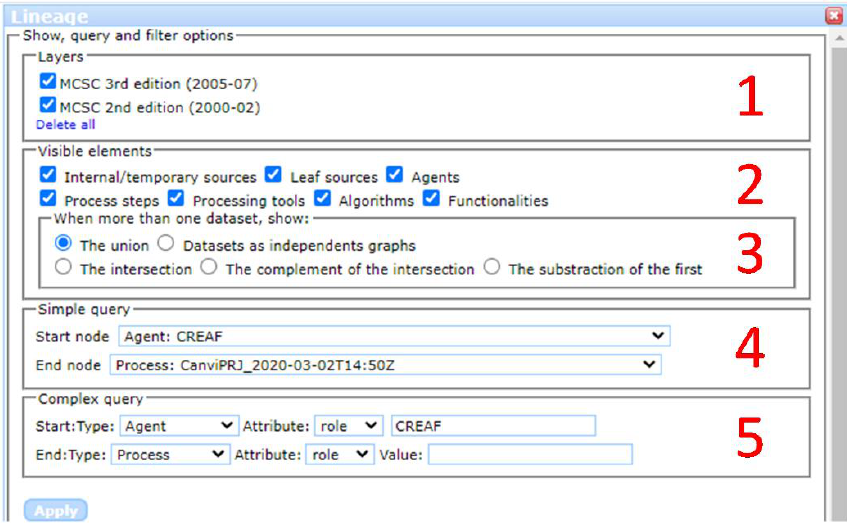
Figure 10. Visibility query and filter options panel: 1 —Layers panel. 2 —Lineage elements fil- tered/visible panel. 3 —Lineage fusion options. 4 —Simple queries panel. 5 —Complex queries panel.